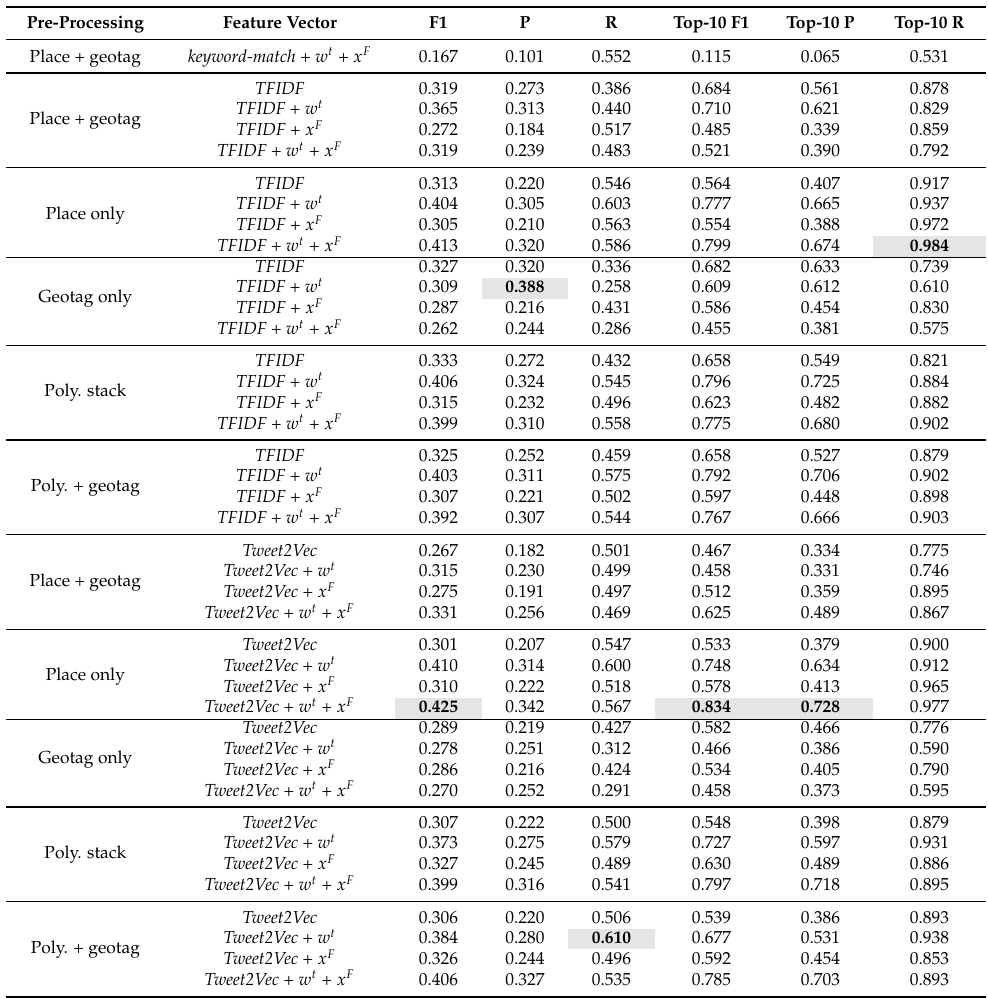
Table 2. Test F1, precision, and recall scores for varying pre-processing and feature vector construction methods. The best results for each metric are